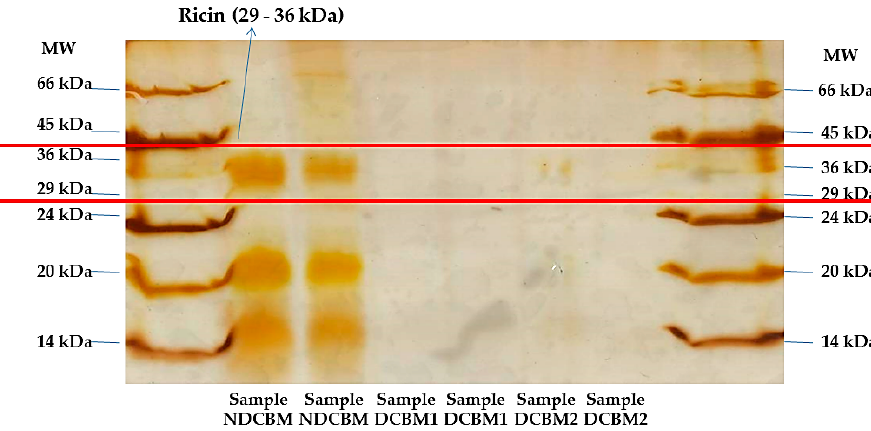
Figure 2. Gel stained with silver nitrate. MW, Molecular weight; NDCBM, Non-DCBM; DCBM1, Sample 1 of DCBM; DCBM2, Sample 2 of DCBM.